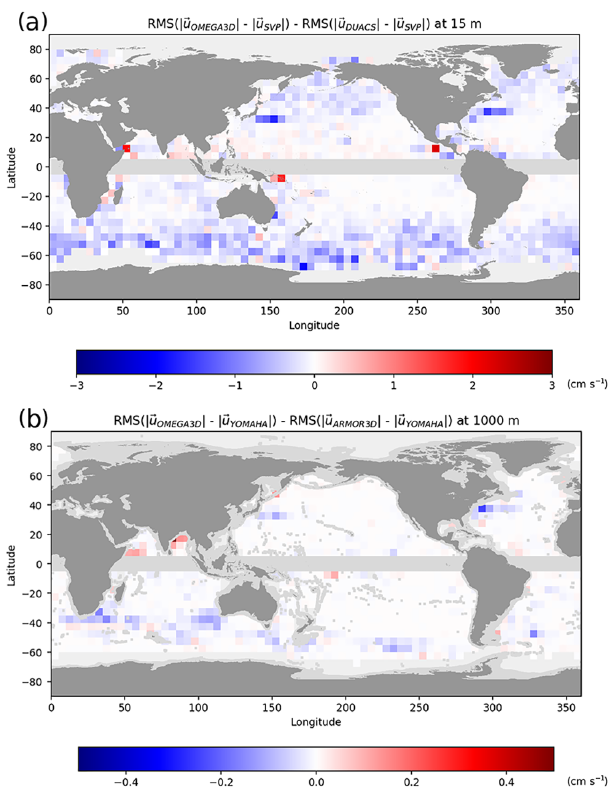
Figure 5. RMSD of OMEGA3D quasi-geostrophic and geostrophic horizontal velocities vs. drifters in 5 ◦ × 5 ◦ bins at 15m (a) and 1000m (b) depth. Negative values indicate an improvement with respect to